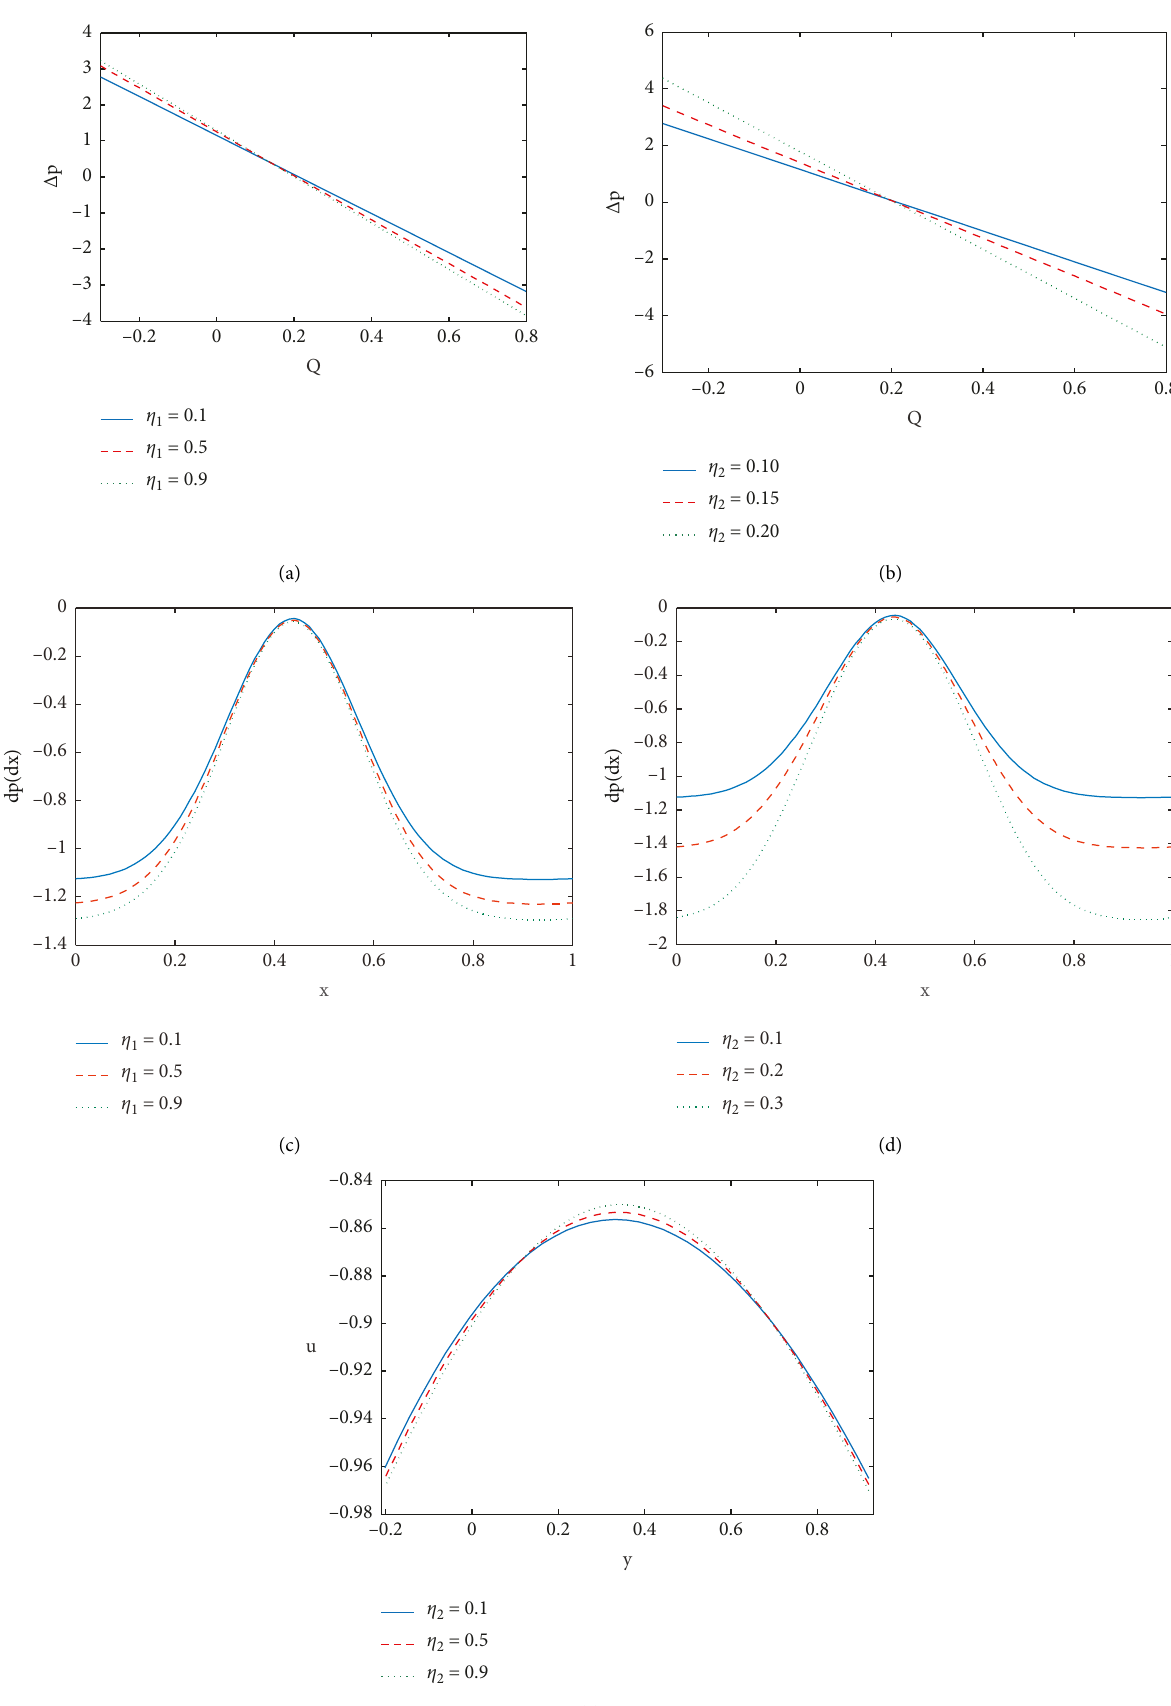
Figure 8: Effects of non-Newtonian parameters ( η